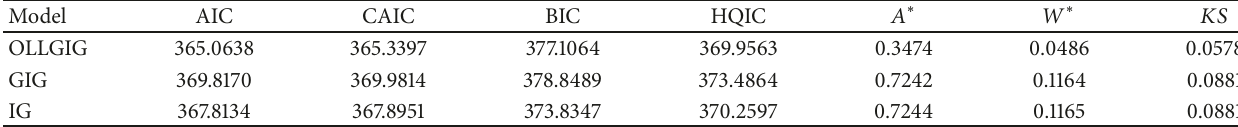
Table 5: Goodness-of-fit measures for the iris data.